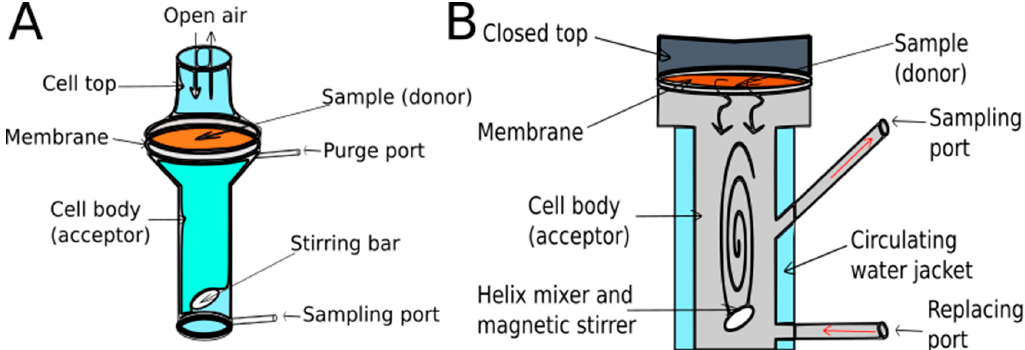
Figure 6. Open ( A ) and closed ( B ) vertical Franz diffusion cells.